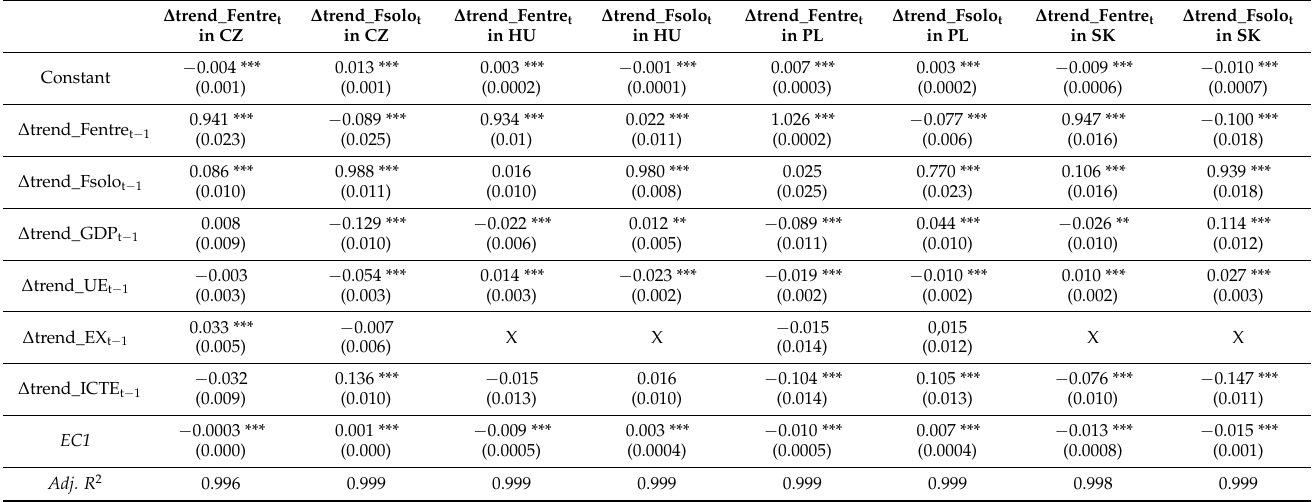
Table 5. Parameters of regression function estimations of long-term